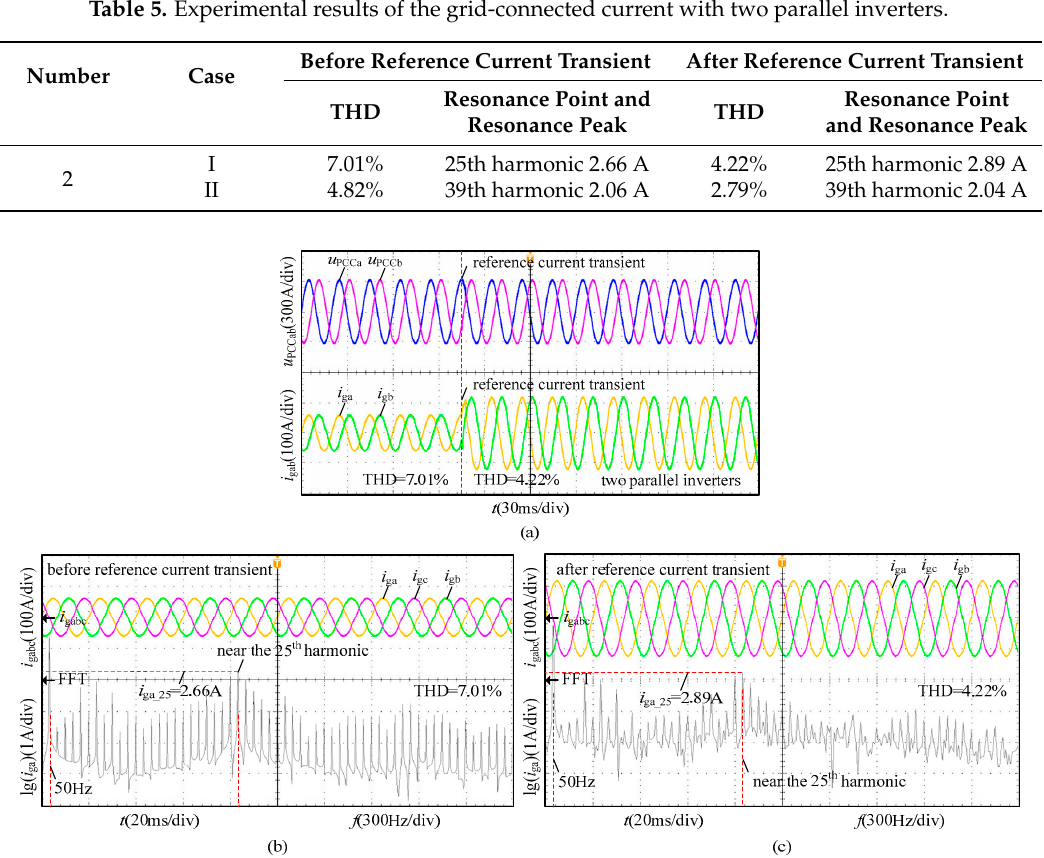
Figure 17. Experimental waveforms of PCC voltage u PCC and grid-connected current i g in case I during reference current transient (two parallel inverters). ( a ) PCC voltage u PCC and grid-connected current i g ; ( b ) grid-connected current i g and spectrogram (before); ( c ) grid-connected current i g and spectrogram (after).